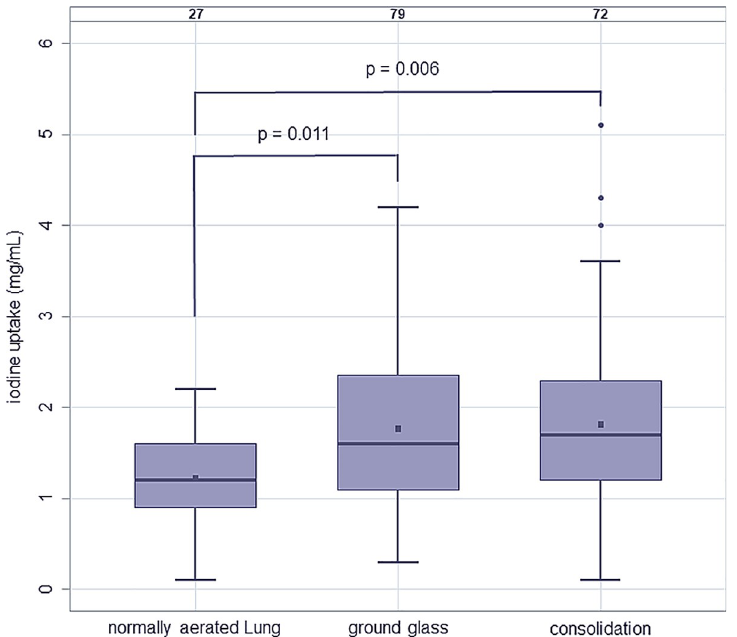
Fig 5. Iodine uptake (mg/mL) of normally aerated lung (estimated mean: 1.22; 95%-CI: 0.95–1.49), areas of ground-glass opacification (estimated mean: 1.77; 95%-CI: 1.52–2.02), and consolidation (estimated mean: 1.82; 95%-CI: 1.56–2.08) without upstream pulmonary